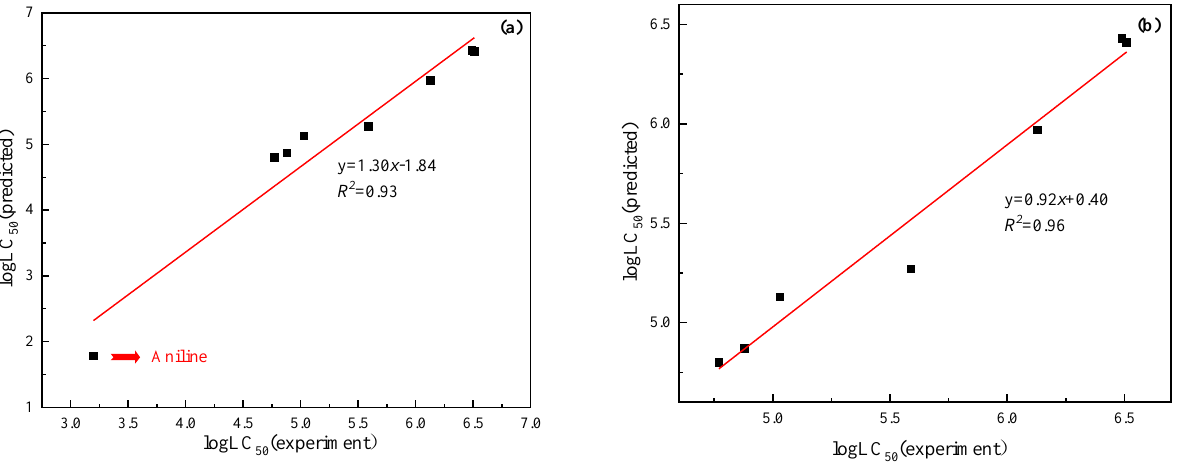
Figure 3. QSAR-model fitting correlation curve between predicted and experimental values of benzene derivatives (( a )—Correlation curve between predicted LC 50 and experimental LC 50 without TRO method; ( b )—Correlation curve between predicted LC 50 and experimental LC 50 by TRO method; The red line showed the fitting effect of the model).